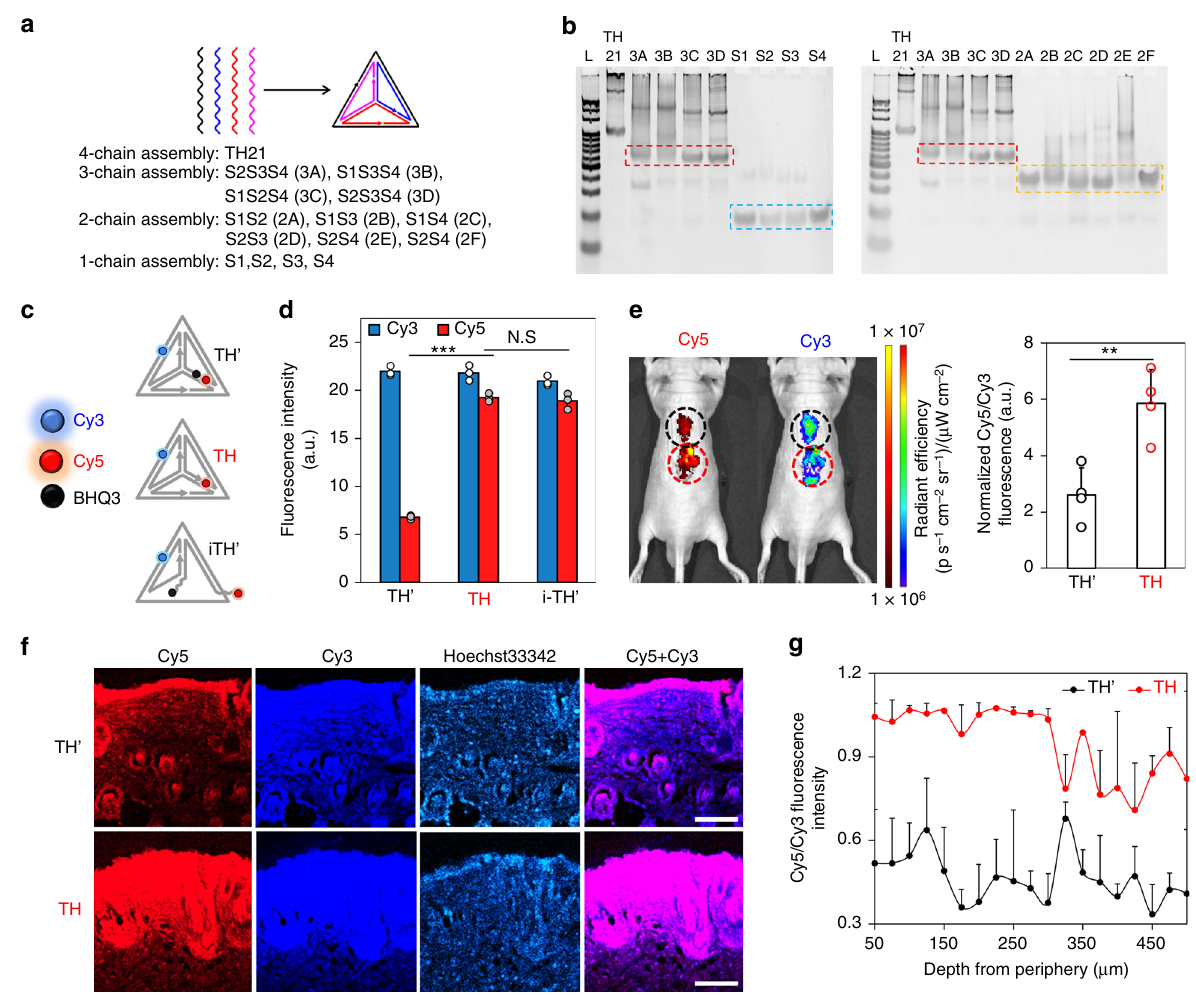
Fig. 3 Assessing integrity of FNAs during their skin penetration: a All assembly permutations from 4 TH21 component chains (S1, S2, S3, S4). b Gel electrophoresis study of all assembly in a (L: 10 bp-ladder, dotted boxes show similar distance traveled for assemblies with 1, 2, or 3 chains). c Design of dual-tagged quenched TH ’ , unquenched TH and incomplete TH ’ (i-TH ’ ). d Cy3 and Cy5 fl uorescence intensities of TH ’ , TH and i-TH ’ (Blue and red column, respectively). Close proximity of BHQ3 to Cy5 fl uorophore results in low Cy5 yield in intact TH ’ . Topical application of TH ’ and TH on mice: e IVIS in vivo imaging and quanti fi cation of Cy3 and Cy5 intensity ratio (black circle: TH ’ , red circle: TH); f fl uorescence imaging of histological sections (red: Cy5, dark blue: Cy3, light blue: Hoechst33342, and merged: Cy5&Cy3 channel) and g the related signal quanti fi cation ratio (Cy5/Cy3) of treated skin (black line: TH ’ , red line: TH). Each dot on bar charts represents independent sample measurement. Source data are provided as a Source Data fi le. Scale bar: 200 μ m. Error bars represent standard deviation. N.S represents non-signi fi cance, ** p < 0.01 and *** p < 0.001 (one-way